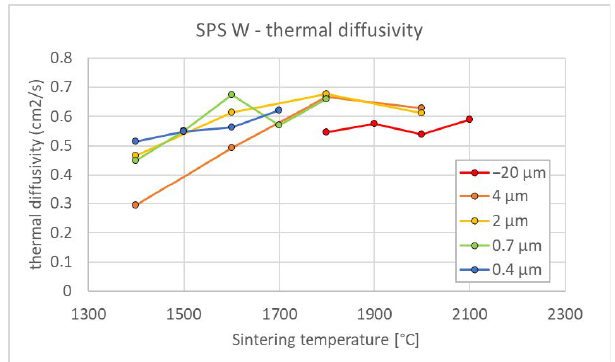
Figure 5. Influence of sintering temperature and powder size on the thermal diffusivity of tungsten compacts (measured at 100 °C). Typical coefficient of variation of the thermal diffusivity measure- ments is about 5% [17].